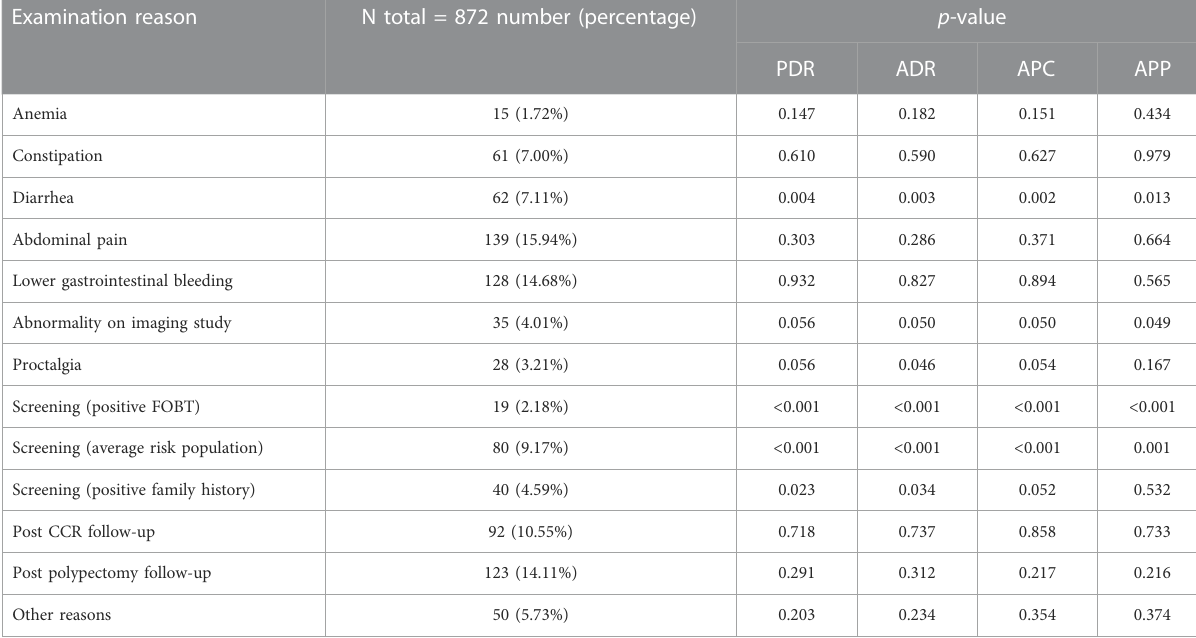
TABLE 6 Correlation between the indication for colonoscopy and PDR, ADR, APC, and APP calculation.